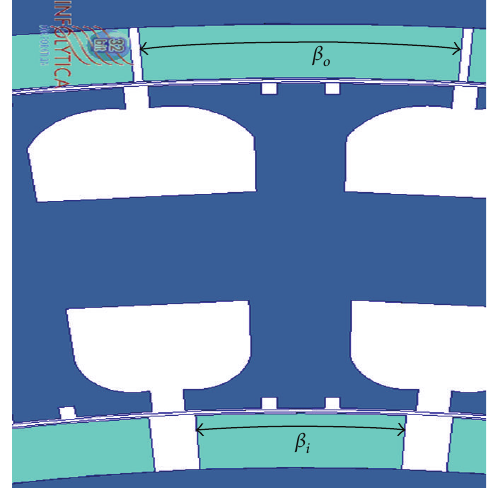
Figure 7: Section of FEA model showing change in magnet pole arc width.